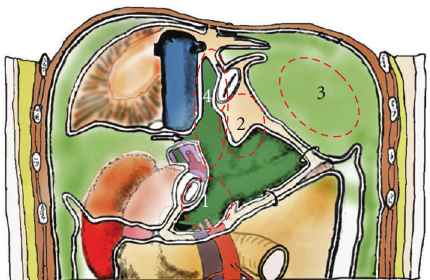
Figure 5: The parts of gastric wall liable to involvement by the disease process (dotted line): (1) the posterior wall of the antrum in the vestibule of the omental bursa, (2) the mid-lesser curvature, which are invaded from the metastasis of lesser omentum, and (3) the upper greater curvature by the invasion from splenic hilar metastasis. Region 4 is named as superior omental recessus, which is frequently involved in pseudomyxoma peritonei.